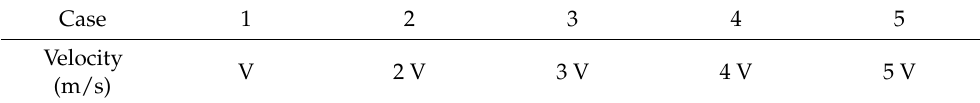
Table 1. Velocities used in entry with constant velocity